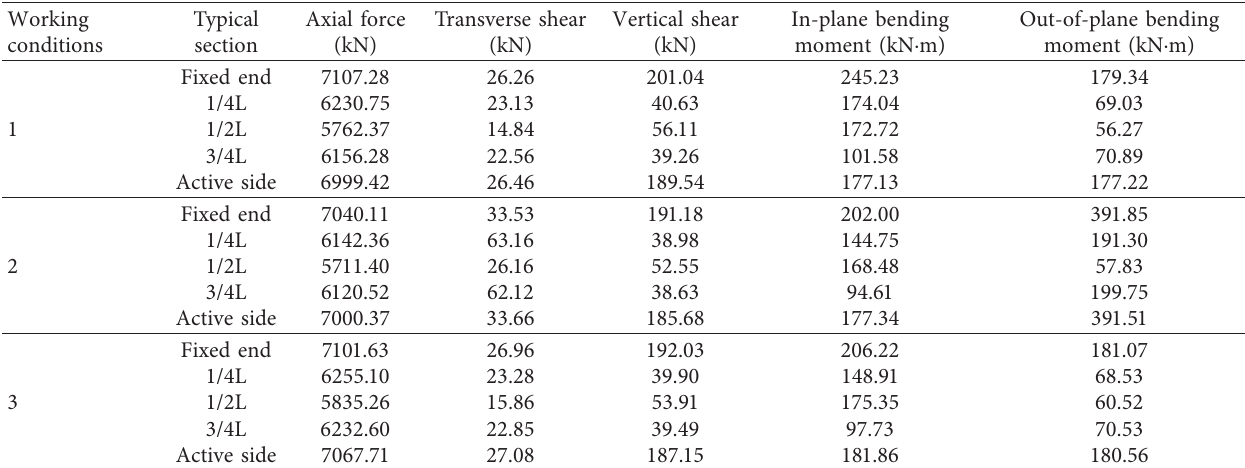
Table 4: The peak values of the internal force of the bridge.